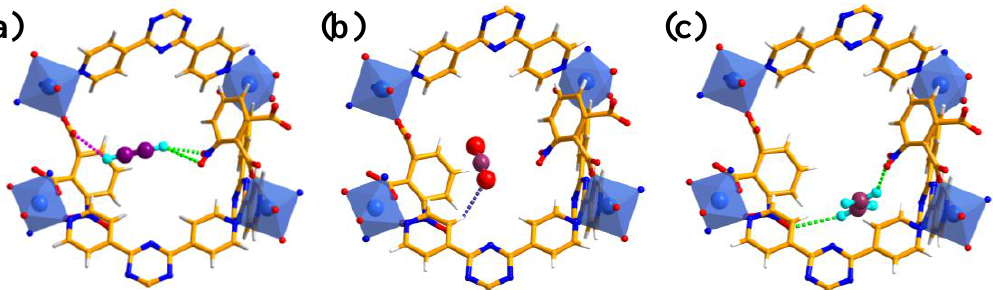
Figure 5. The GCMC calculated adsorption sites of C 2 H 2 ( a ), CO 2 ( b ), and C 2 H 4 ( c ) in NUM-14a at 298 K and 1 bar.